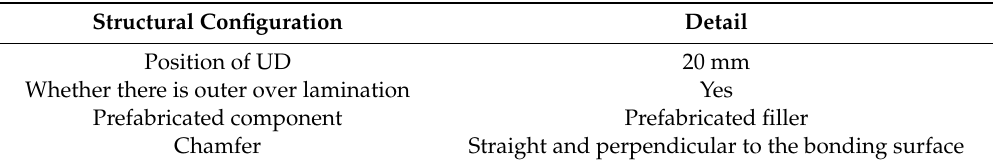
Table 1. Structural configurations of the benchmark model.